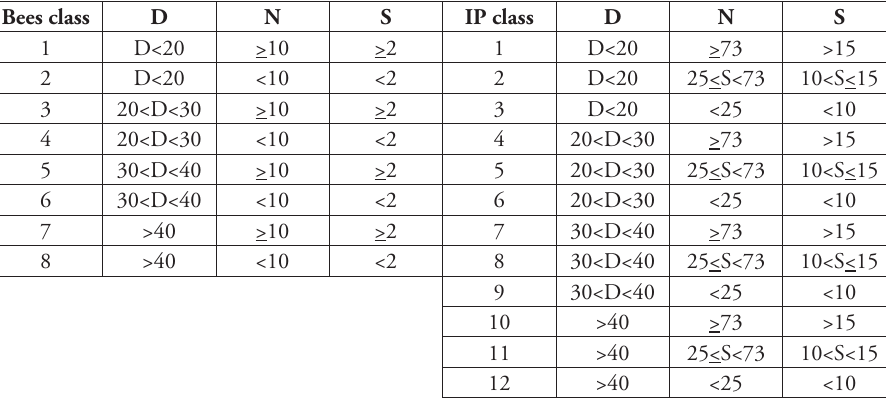
Table 1. Distribution of disturbance index (D) for bees’ and insect pollinators’ abundance (N) and rich- ness (S) per